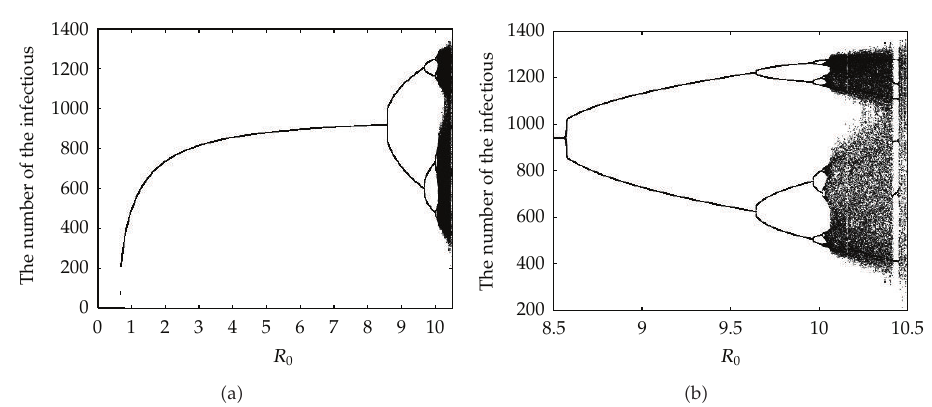
Figure 4: Period doubling bifurcation of model (cid:2) 3.9 (cid:3) . Parameter values are p (cid:5) 0 . 994, Λ (cid:5) 10, α (cid:5) 0 . 03, (cid:5) 0 . 5, k (cid:5) 0 . 3, k (cid:5) 0 . 2, m (cid:5) 0 . 1, and β (cid:5) 0 . 5. γ (cid:5) 0 . 1, k 1 2 3 2 Λ (cid:5) 10, α (cid:5) 0 . 03, γ (cid:5) 0 . 1, k (cid:5) 0 . 5, k (cid:5) 0 . 3, k (cid:5) 0 . 2, m (cid:5) 0 . 1, β 1 2 3